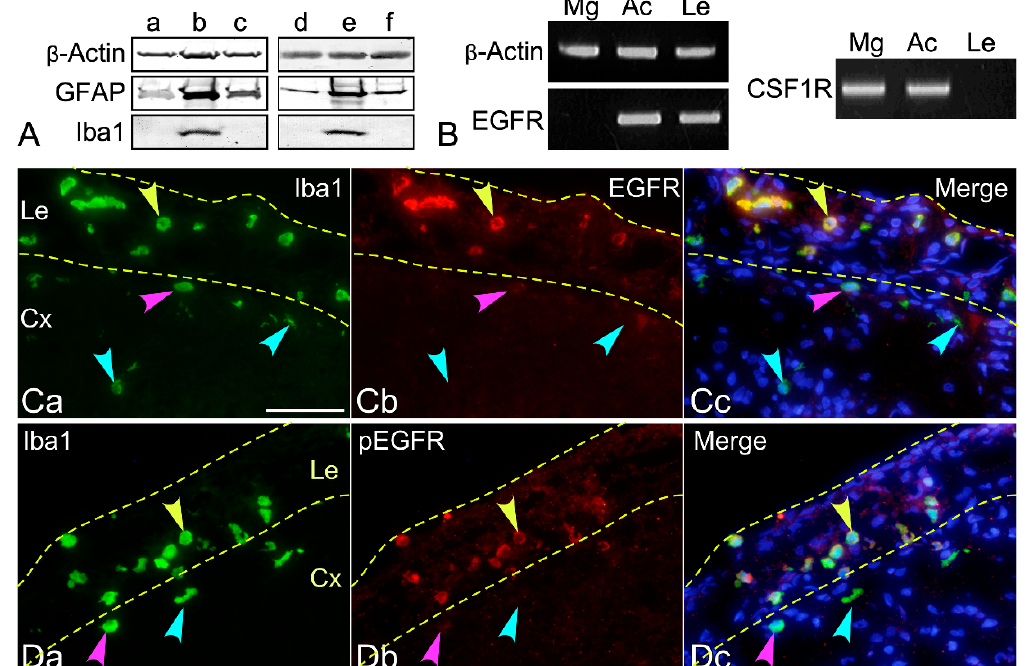
Figure 4. Effects of cytokines or growth factors on the generation of GFAP + and Iba1 + cells as revealed by immunoblotting ( A ), and the expression of EGF receptor (EGFR) by leptomeninges ( B – D ). Leptomeninges are surrounded by dotted lines in ( C , D ). ( A ) Two separate dissociated leptomeningeal cultures from neonatal rats of different dams (a–c and d–f) were maintained for 6 days in serum ‐ free medium (E2) alone (a), or E2 containing EGF (b and e), colony ‐ stimulating factor 1 (CSF1) (c), basic fibroblast growth factor (bFGF) (d), or granulocyte macrophage colony ‐ stimulating factor (GM ‐ CSF) (f), while they were forming cell aggregates. The aggregates were then cultured in FCS ‐ DMEM for 2 days, followed by im ‐ munoblotting using antibodies against β‐ actin, GFAP, or Iba1. Iba1 immunoreactivity was observed only when the cells were cultured in the presence of EGF. GFAP immunoreactivity was most enhanced in the presence of EGF. ( B ) mRNA encoding EGFR was expressed by primary cultured astrocytes (Ac) and freshly isolated leptomeninges of the neonatal rat brains (Le), while primary microglia (Mg) did not express EGFR mRNA, as revealed by RT ‐ PCR. mRNA encoding CSF1R was expressed by Mg and Ac, while Le did not express CSF1R mRNA. ( C ) EGFR expression by Iba1 + macrophages (green, denoted by a yellow arrowhead) in the leptomeninges (Le) of the neonatal rat brain was immunohistochemically de ‐ tected. Amoeboid microglia (green, denoted by a pink arrowhead) in the cerebral cortex (Cx) weakly expressed EGFR (red). Amoeboid microglia in the deeper layer and ramified microglia (denoted by blue arrowheads) did not express EGFR. Astrocytes were EGFR ‐ . Nuclei were stained blue by Hoechst 33258. ( D ) Immunoreactivity of phosphorylated EGFR (pEGFR, red) was also detected in macrophages in the leptomeninges (green, denoted by a yellow arrowhead), but not in most microglia in the parenchyma (green, denoted by a blue arrowhead). A few amoeboid microglia in the cortex (green, denoted by a pink arrowhead) weakly expressed pEGFR (red). Scale bar = 50 μ m.